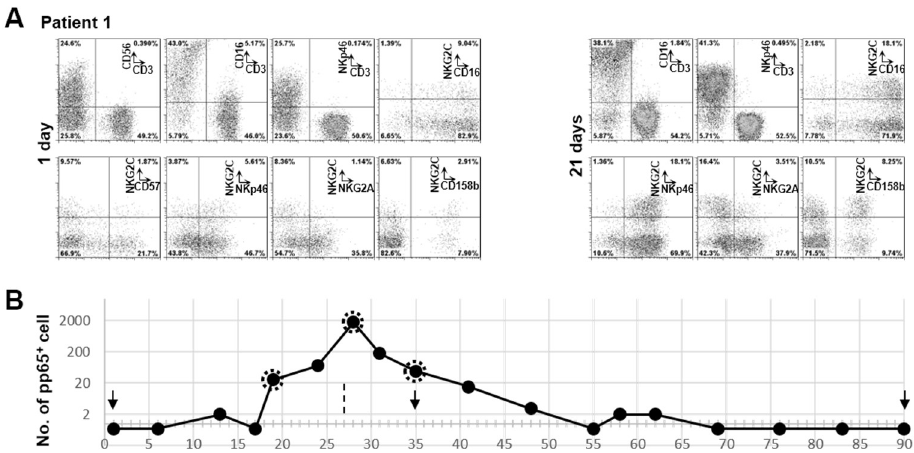
Figure 3. Dynamic expansion of RAGS − / DCLRE1C − -NK cells post HCMV active infection. ( A ) PBMCs from 1 day or 21 days post HCMV detection from patient 1 were stained with indicated mAb. After gating on lymphocytes, CD3 / CD56, CD3 / CD16 and CD3 / NKp46 were used to identify NK cells. The expressions of CD57, CD16, NKp46, NKG2A and CD158b on NKG2C + NK cells were analyzed after gating on CD3 − CD56 + lymphocytes. ( B ) Virus detection from patient 1. The numbers of pp65 positive cells per half million of polymorphonuclear leukocytes were plotted with the days post HCMV detection. The dates of urine test are indicated with arrows. The date of bone marrow transplantation is indicated with a dashed line. The dashed circles indicate viruses that were isolated by culturing polymorphonuclear leukocytes from peripheral blood with indicator cells.